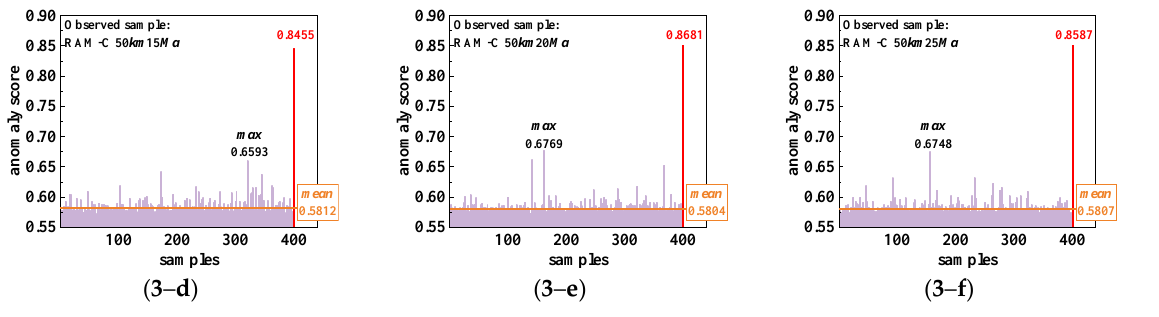
Figure 12. Anomaly scores of subclasses and data streaming. ( 1 ) Condition 1. ( 2 ) Condition 2. ( 3 ) Condition 3. ( a ) 40 km 15 Mach. ( b ) 40 km 20 Mach. ( c ) 40 km 25 Mach. ( d ) 50 km 15 Mach. ( e ) 50 km 20 Mach. ( f ) 50 km 25 Mach.